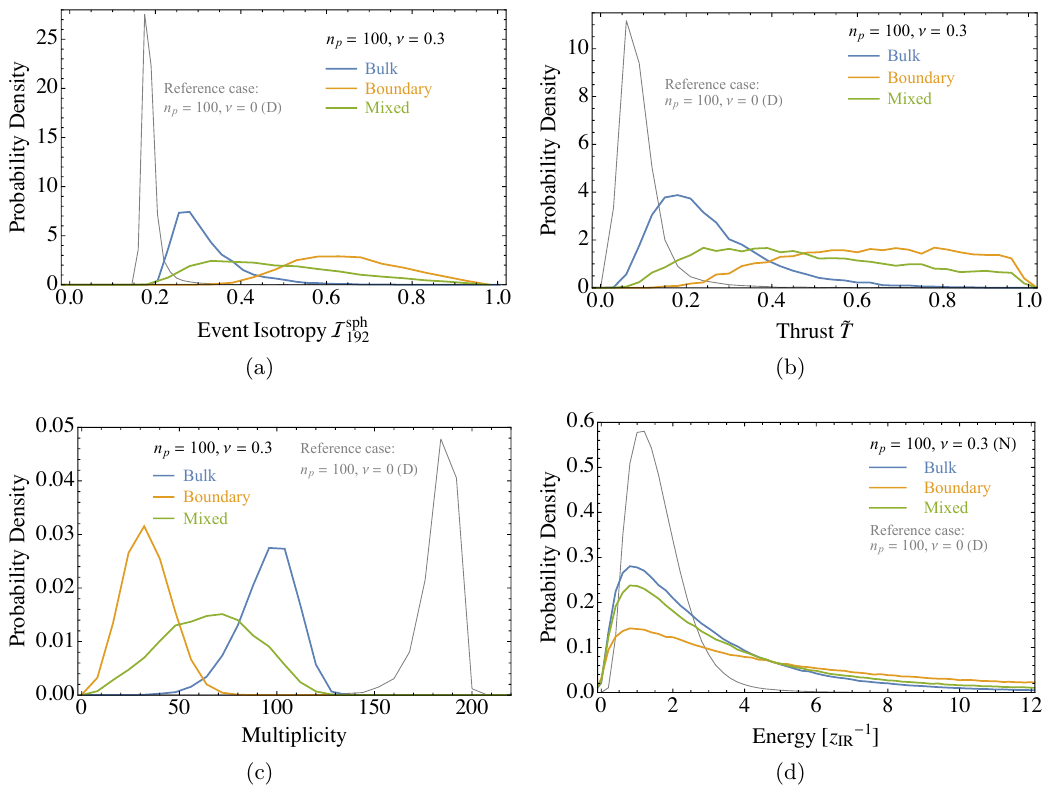
; (b) rescaled thrust ˜ T ; (c) particle multi- Figure 12 . The distributions of (a) event isotropy I sph 192 plicity; and (d) energy of final-state particles for three different scenarios, all with ν = 0 . 3 , Neumann boundary conditions, and a decay cascade beginning with the 100 th KK mode. The couplings are: in blue, pure bulk ( ˜ c = 0 ); in orange, pure boundary ( c = 0 ); in green, a mixed case ( ˜ c = 0 . 015 c